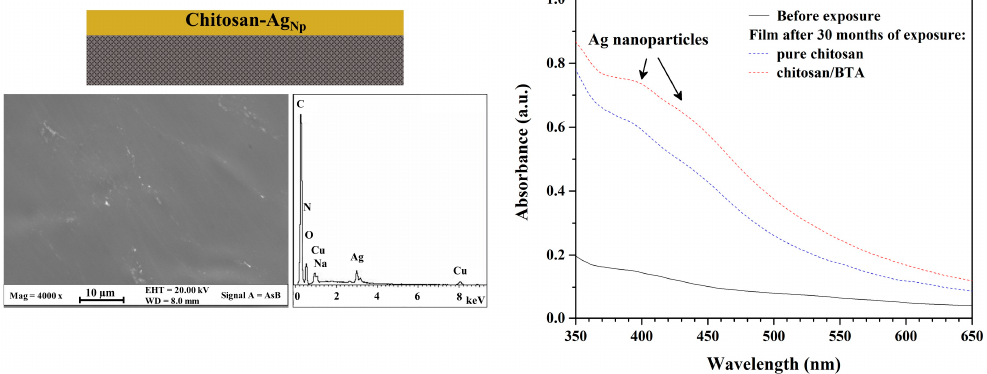
Figure 4. Effects of short- and long-term interactions between the chitosan-based coatings and the silver alloy. ( a ) Graphical illustration of chitosan and chitosan/BTA coatings’ appearance after 10 h of accelerated degradation treatment. FE-SEM images and relative EDS spectra show morphology and chemical composition of the coatings; ( b ) Graphical illustration of a chitosan coating representative of both pure chitosan and chitosan/BTA films’ appearance after 30 months of storage inside the wooden box. FE-SEM images and relative EDS spectra show morphology and chemical composition of the coating, while UV-Vis spectra show absorptions typical of silver nanoparticles.